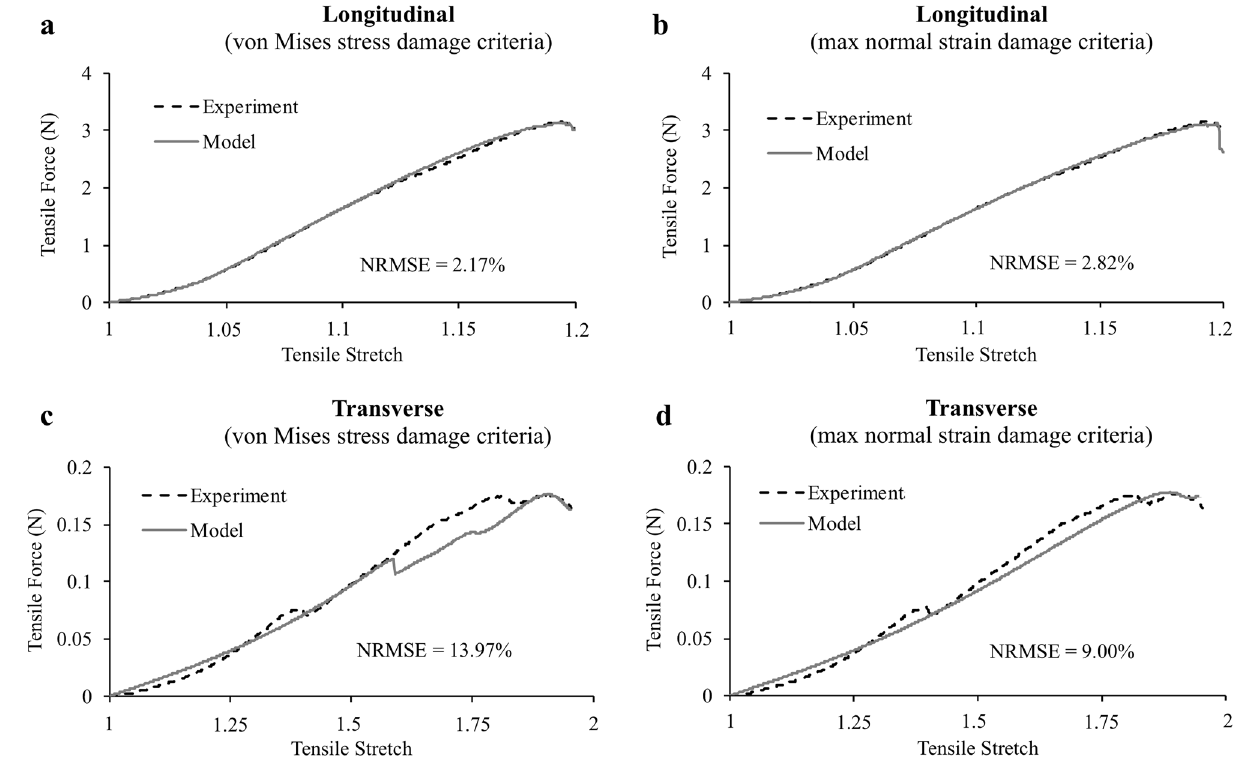
Figure 5. Representative model fits to experimental grip-to-grip force–displacement curves (we converted grip displacement to tensile stretch). ( a ) When modeling the fiber response (longitudinal), von Mises stress damage criterion had better fits compared to the ( b ) maximum normal strain damage criterion. ( c ) However, von Mises stress damage criterion had slightly poorer quality of fits compared to ( d ) maximum normal strain damage criterion when modeling the ground substance (transverse).